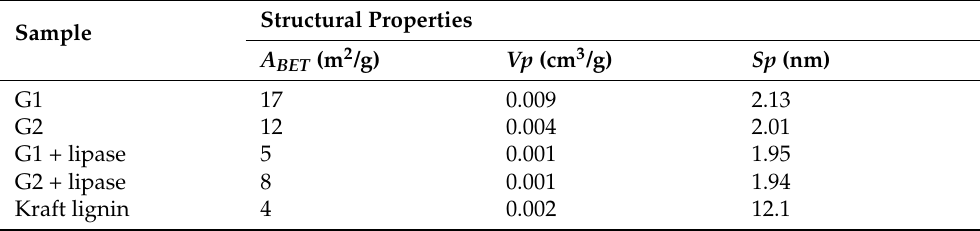
Table 2. Porous structure properties of the analyzed